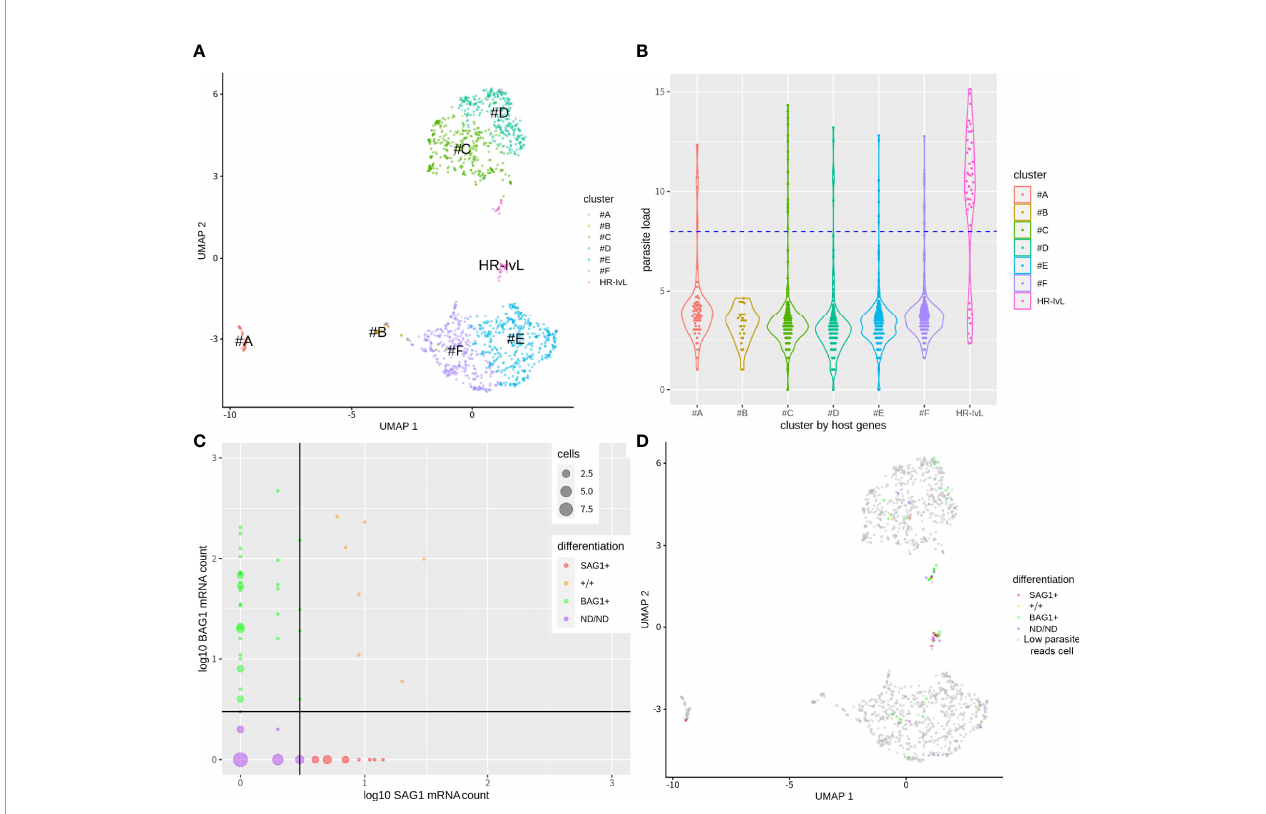
FIGURE 2 | Clustering of host cells in bradyzoite-induced culture with single cell transcriptome. (A) Single cell level transcriptome of parasite-exposed host cells in bradyzoite induction condition. Host cell transcriptome was used for the clustering of host cells. HR-IvL: a cluster with a high ratio of infected cells vs. cells low parasite reads . (B) Log 2 transformed mRNA molecule counts mapped to parasites were plotted to indicate parasite load per cell for each cluster. By counting the number of infected cells using immuno fl uorescence analysis, infection rate was estimated as 5.1%. The top 5.1% cells in parasite-mapped mRNA counts were assigned as infected cells. Blue dots line shows the cut-off level to separate putative infected and cells low parasite reads . (C) Infected cells were further plotted for the expression of canonical tachyzoite marker SAG1 and bradyzoite marker BAG1. Log 10 values of mRNA count + 1 for each gene are shown. The cut-off line of raw mRNA count number above three was used to assign each cell as positive for SAG1/BAG1. A total of 78 putative infected cells were divided into 39 BAG1+, 11 SAG1+, 7 +/+, and 21 ND/ND cells. Size of dots show the cell number which shares the same mRNA count number. (D) Parasite differentiation category are overlayed with host cell